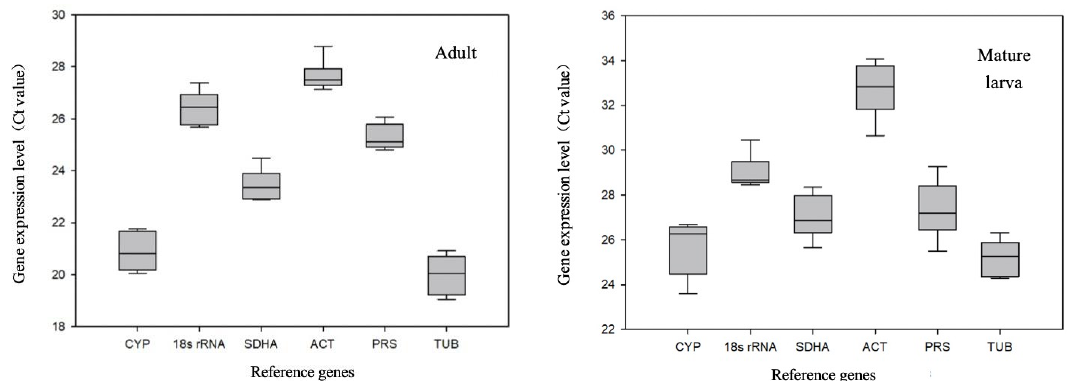
Figure 1. Expression levels of candidate reference genes in adults and mature larvae of D. valens. Expression levels are displayed as raw cycle threshold (Ct) values of the candidate reference genes of D. valens at different temperatures. The boxes represent the values between the 25th and 75th percentiles, the lines in the boxes indicate the median values, and the whisker caps denote the minimal to maximal values.